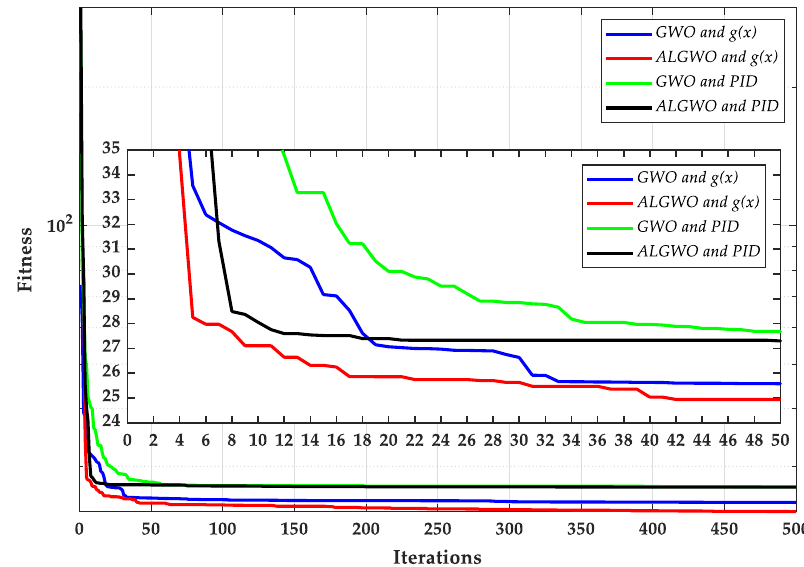
Figure 13. The comparison results of algorithm optimization search on test system 5.